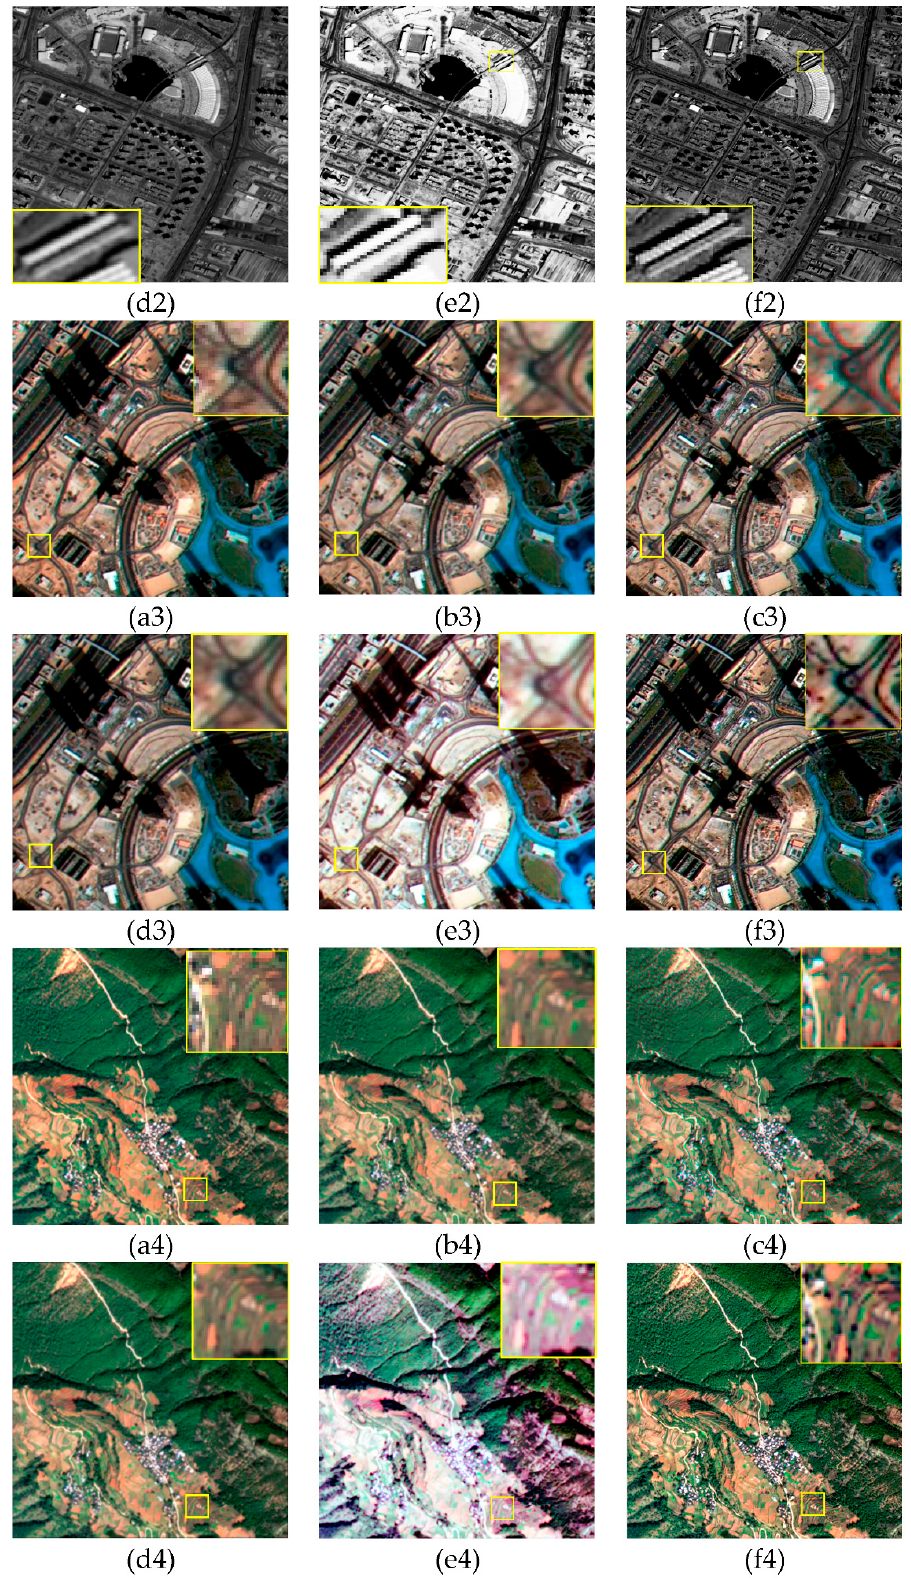
Figure 4. Simulation experimental results ( a ) Bicubic; ( b ) iteration back-projection (IBP); ( c ) SR using deep convolutional networks (SRCNN); ( d ) very deep convolutional networks (VDSR); ( e ) histogram equalization (HE); ( f ) SR based on multilevel main structure and detail boosting (MMSDB-SR).